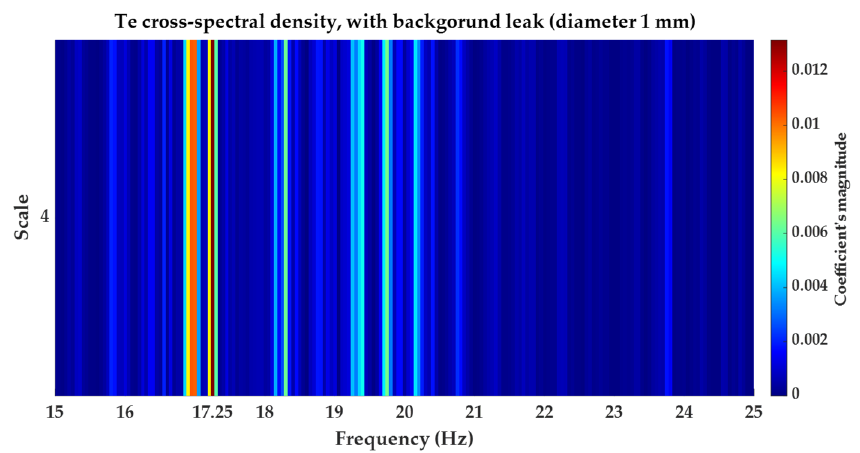
Figure 14 . 𝒯 (cid:3032) cross-spectral density in Scale 3 , with background leak ( 1 mm in diameter) and flow rate 33.7 mL/s . Figure 15. 𝒯 (cid:3032) coherence, with background leak ( 1 mm in diameter) and flow rate 33.7 mL/s .